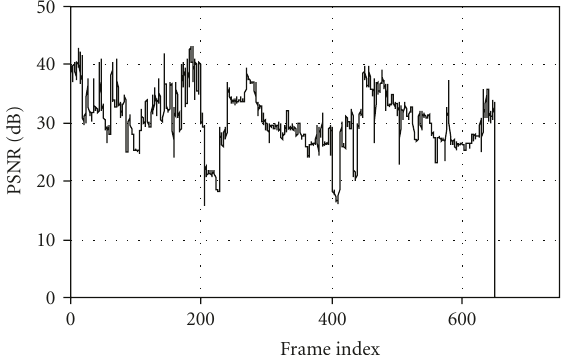
Figure 19: PSNR over the 750 frames of the input video, under a fixed power budget with the default ARQ with